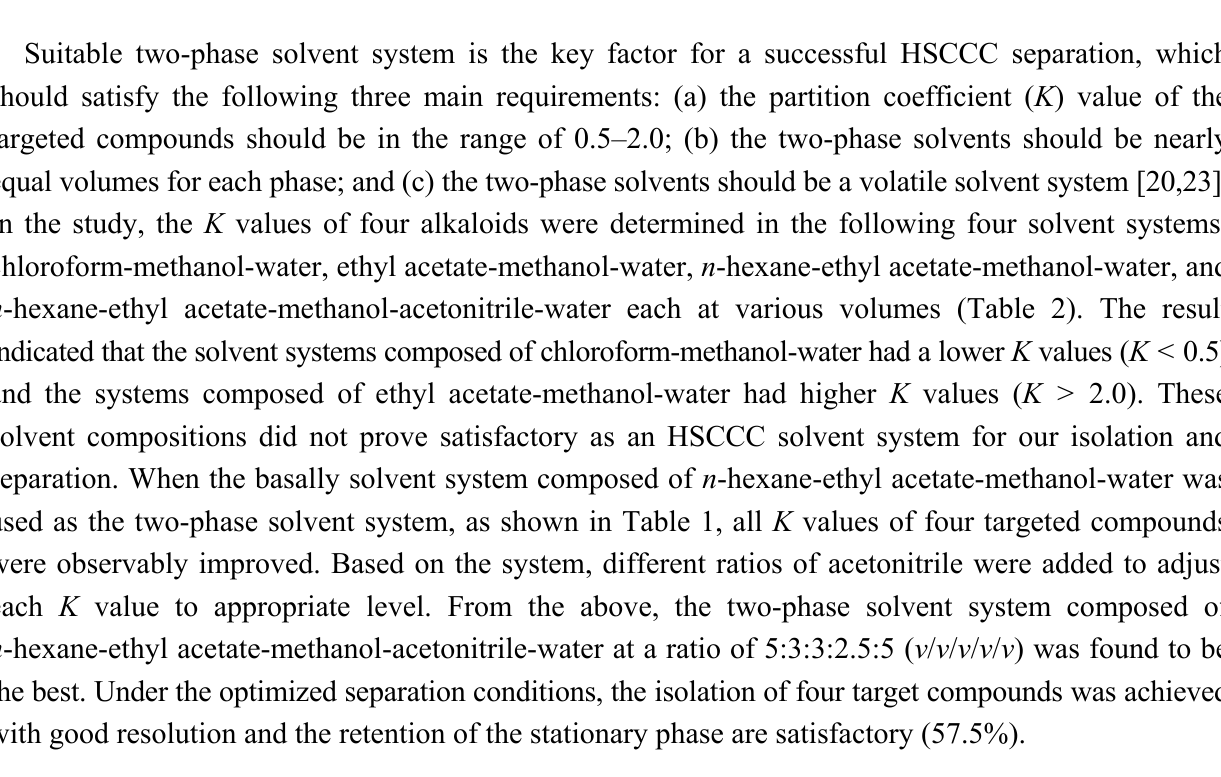
Table 2. The K (partition coefficient) values of four alkaloids in different solvents